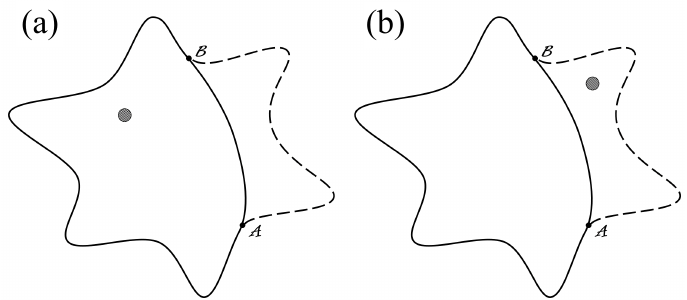
Figure 9: Parity of antiferromagnetic bonds along homotopic loops. The dashed circles represent defects - elementary loops with an odd number of antiferromagnetic bonds. These circles constitute holes in the space of the even bond